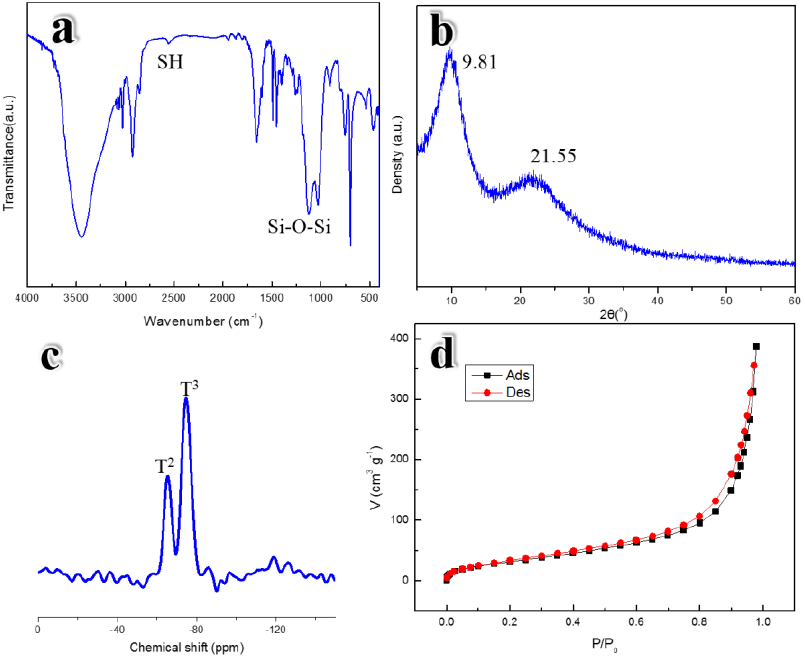
Figure 2. Characterization of HSOS particles. ( a ) FTIR spectrum, ( b ) XRD pattern, ( c ) 29Si NMR spectrum and ( d ) N2 adsorption–desorption isotherm.